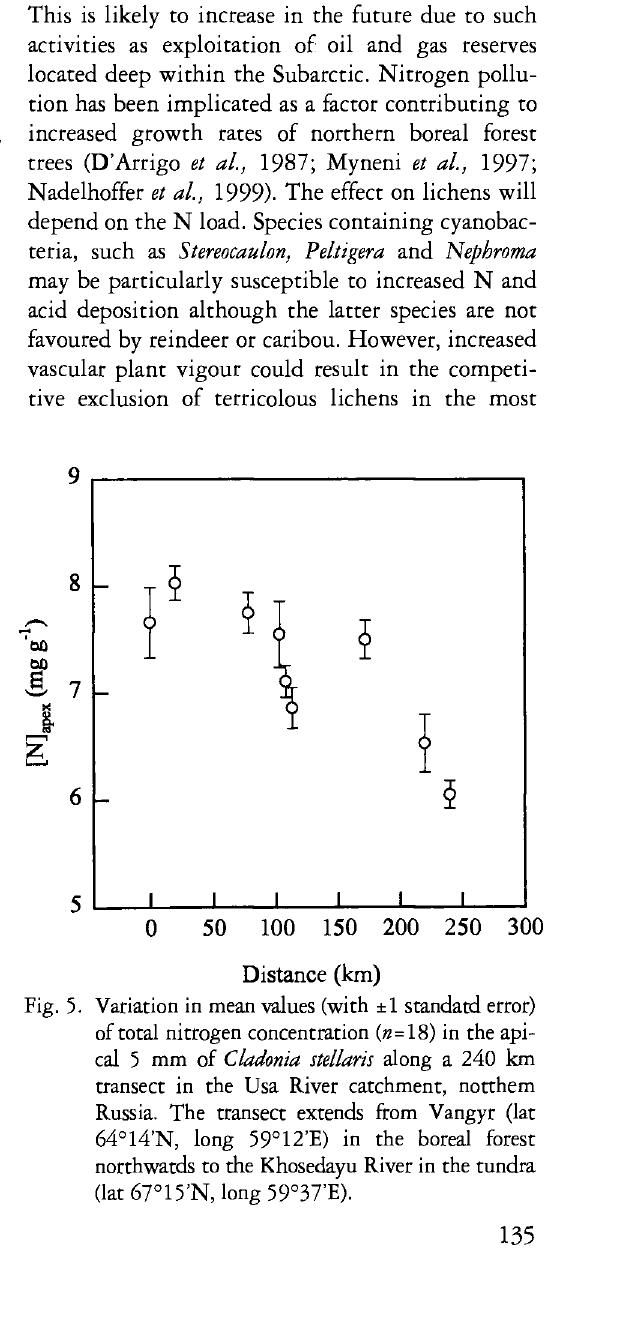
Fig. 4. The relationship between mean values (with ± 1 standard error) of total nitrogen concentration («=5-10) in a horizontal stratum of Cladonia por- tentosa between 40-50 mm from the thallus apices ([N] .) and wet deposition of NO3 as a function baS( of total N deposition.